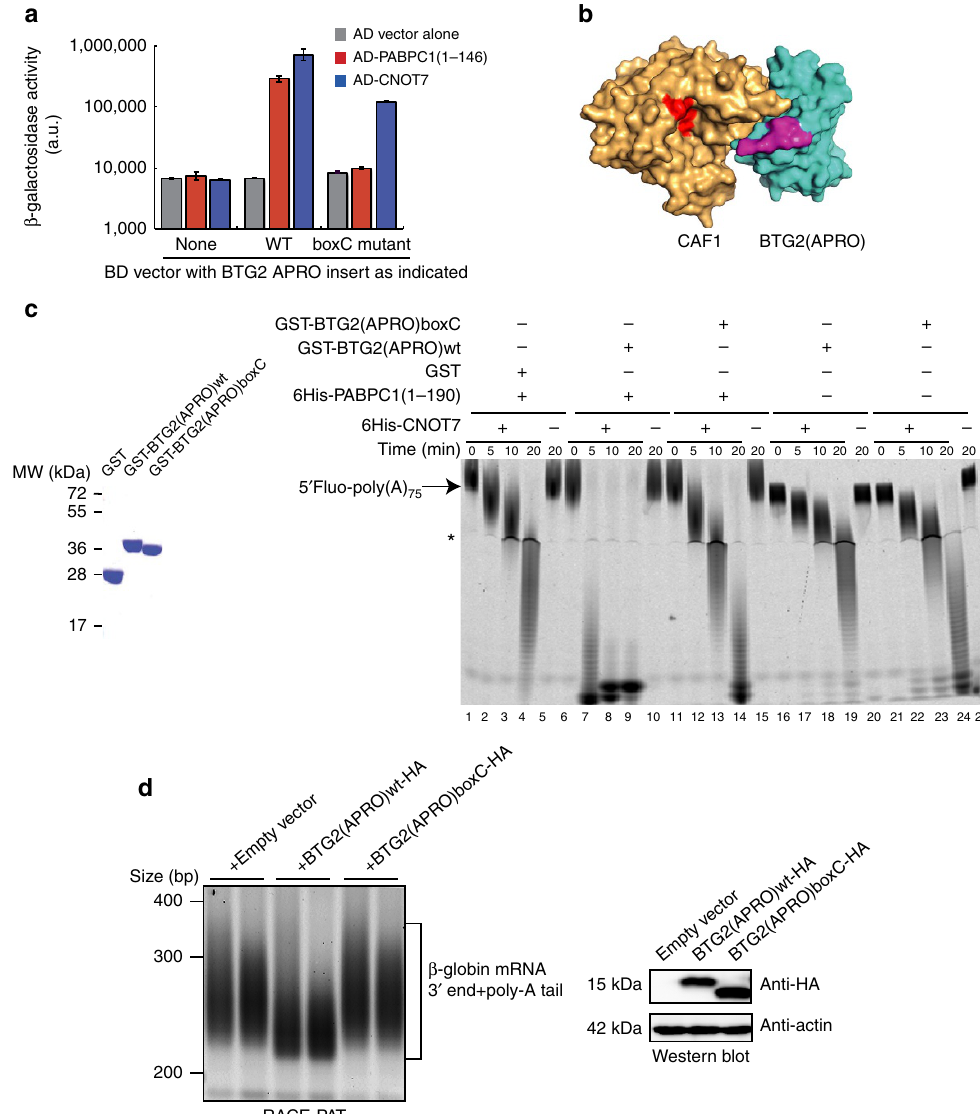
Figure 4 | Mutation of the boxC motif impairs BTG2 APRO domain binding to PABPC1 RRM domains and mRNA deadenylation. ( a ) Interaction of wild-type (WT) and mutant BTG2 APRO domains with the first RRM domains of PABPC1 and CAF1 (CNOT7 paralogue) in yeast two-hybrid assay. The sequence DGSIC of boxC BTG2 motif (amino acids 116–120) was substituted by the sequence found in the Tob1 APRO domain (KGPVK), and the interaction of WT (BD-BTG2(APRO)wt) and boxC-mutated (BD-BTG2(APRO)boxC) BTG2 APRO domains with PABPC1 RRMs (AD-PABPC1(1–146)) and CAF1 (AD-CNOT7) was monitored by b -galactosidase assays. Activities are expressed in a.u. Error bars (s.d.) correspond to two biological replicates. ( b ) Model of the CAF1-BTG2(APRO) complex structure. The previously solved structures of CAF1-Tob1(APRO) (PDB ID 2D5R) and BTG2(APRO) (PDB ID 3E9V) were used to construct a model for the CAF1–BTG2(APRO) structure. CAF1 is shown in light orange with the conserved active-site residues (DEDHD) in red. BTG2 is coloured in blue and the boxC motif (DGSIC sequence) is in magenta. ( c ) In vitro deadenylation with CAF1 (CNOT7 paralogue), first RRM domains of PABPC1 and BTG2 WTor boxC-mutated APRO domains. Five micrograms of the GST fusion proteins used are shown in right panel; the 6His-CNOT7 and 6His-PABPC1(1–190) proteins used are presented in Fig. 3a. Reaction conditions for the in vitro experiments are the same as in Fig. 3b. Experiment was performed twice. CAF1 deadenylation rates in nts per min are 2.7 with GST þ 6HisPABPC1(1–190), 14.4 with GST-BTG2(APRO)wt þ 6HisPABPC1(1–190), 3.4 with GST-BTG2(APRO)boxC þ 6HisPABPC1(1–190), 2.1 with GST-BTG2(APRO)wt and 3.5 with GST-BTG2(APRO)boxC. ( d ) Poly(A)-tail length of the b -globin reporter transcript co-expressed with WT and mutant BTG2 APRO domains. HEK293 Tet-Off cells were co-transfected with plasmids expressing the b -globin reporter and WT or boxC-mutated BTG2 APRO domains or empty expression vector. Fragments comprising approximately 200bp of the 3 0 end of the b -globin mRNA in addition to poly(A) tails were amplified using a RACE-PATassay. Two biological duplicates are shown. A western blot analysis of corresponding cell lysates is shown to demonstrate expression of the BTG2